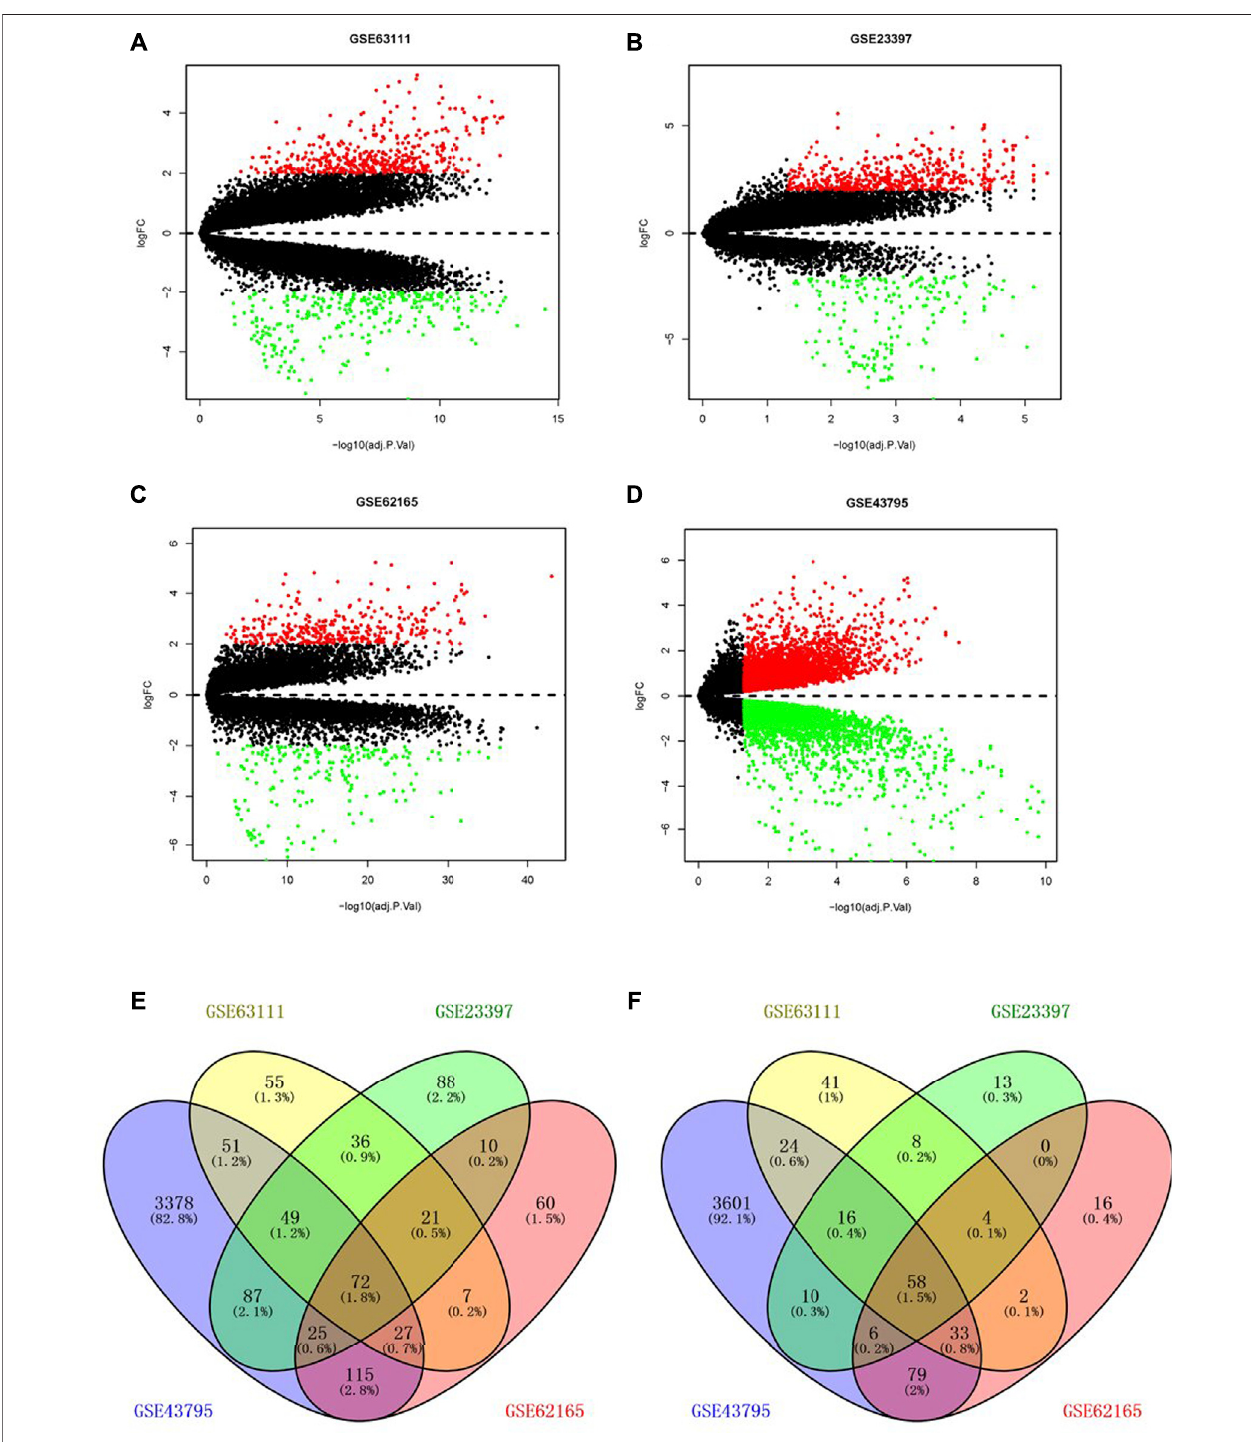
FIGURE1| Screeningofdifferentiallyexpressedgenes.VolcanoplotofGSE63111 (A) ,GSE23397 (B) ,GSE62165 (C) ,andGSE43795 (D) . (E,F) Upregulatedand downregulated DEGs in the GSE63111, GSE23397, GSE62165, and GSE43795. DEGs, differentially expressed genes.